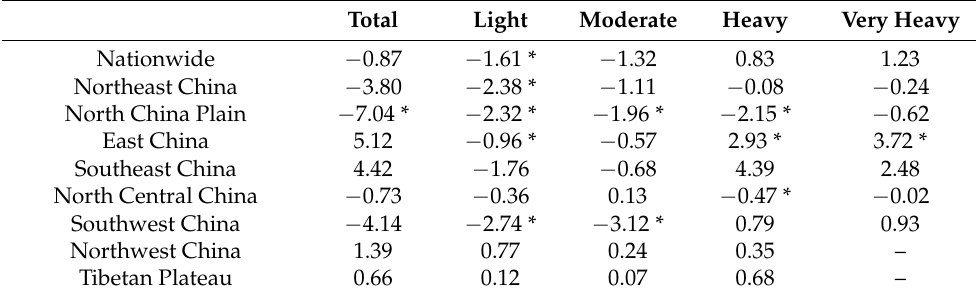
Figure 4. Changes of precipitation amount (mm/decade) (( a ) light precipitation, ( b ) moderate precipitation, ( c ) heavy precipitation, and ( d ) very heavy precipitation) during the rainy season over China from 1960 to 2018. Upward and downward triangles represent positive and negative trends, respectively. Blue and red triangles denote significant trend at the 90% confidence level.